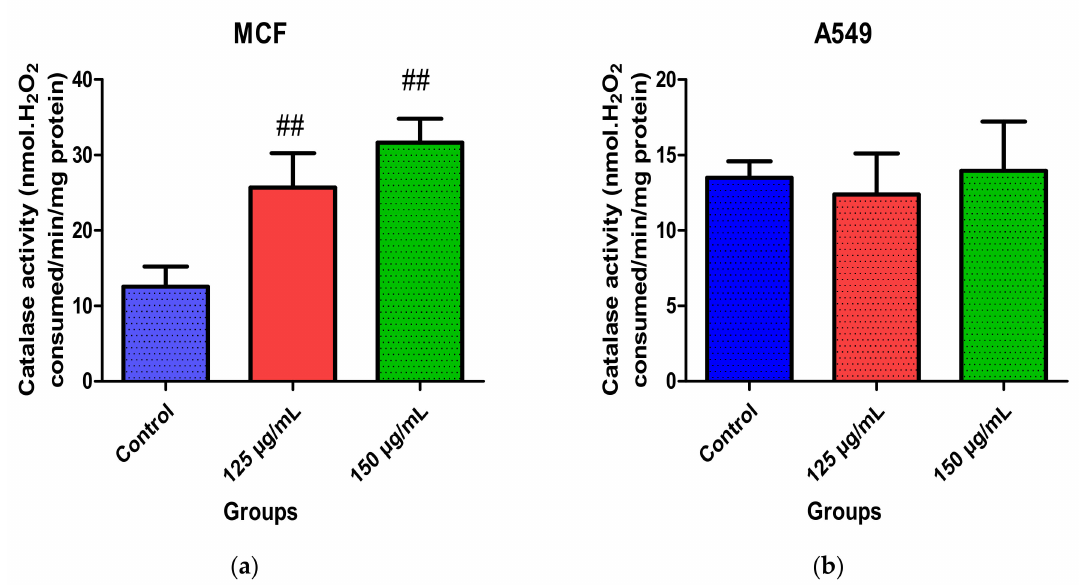
Figure 4. Effect of PUFA-rich extract from Chlorella sp. on catalase activity in ( a ) MCF-7 and ( b ) A549 cells after incubation for 48 h. Bars represent mean ± SEM. Values are statistically different at ## p < 0.05 vs.